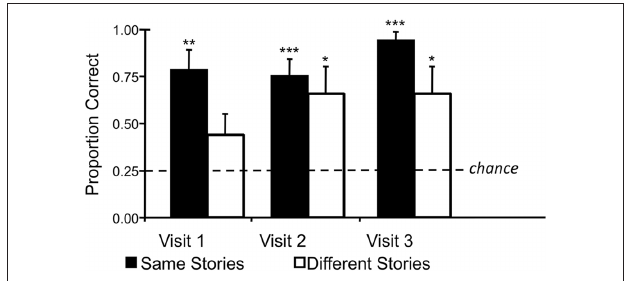
Figure 4 | results from the immediate recall trials as a function of visit. The y -axis represents proportion of correct choices on the four-alternative test trials. The dotted line represents chance (0.25). Error bars represent one standard error of the mean. * p < 0.05, ** p < 0.01, *** p <